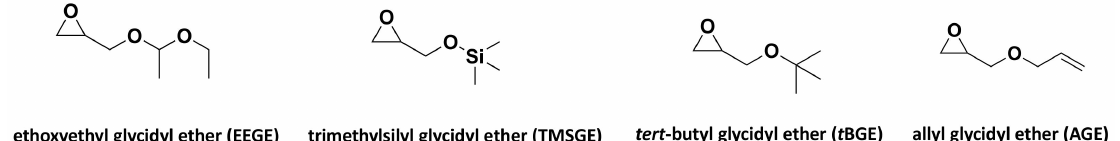
Figure 3. Common protected glycidols for synthesis of linear polyglycerol LPG. Adapted with permission from ref. [7]. Copyright 2014 American Chemical Society.